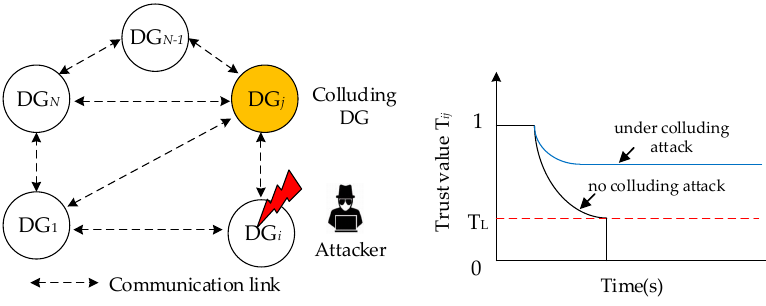
Figure 4. Illustration of colluding attack on the trust evaluation process.